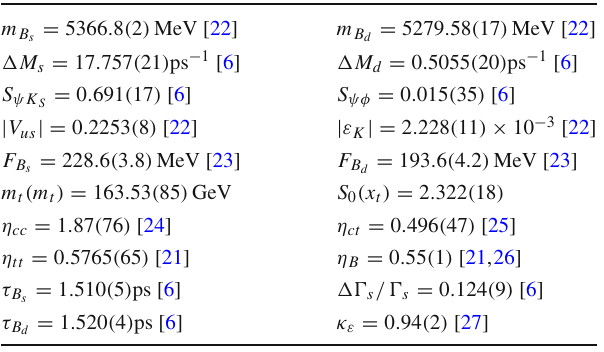
= 5279 . 58 ( 17 ) MeV B d